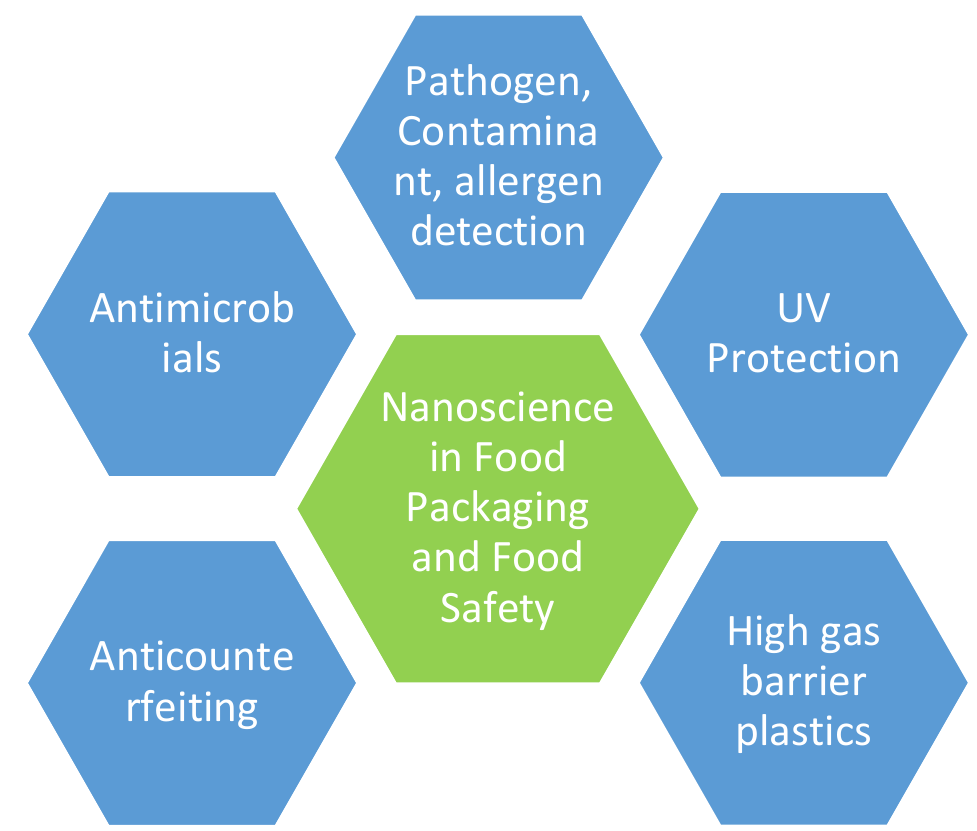
Figure 2. The main applications of nanomaterials in the food industry. A systematic review of eligible studies published during the last decade and related to the applications of silver, copper, and clay NPs in food packaging, is provided in Table 2. Special focus is placed on the migration and antimicrobial properties of the NPs of interest. Several of the most applicable nanomaterials in the food packaging industry are discussed in the following